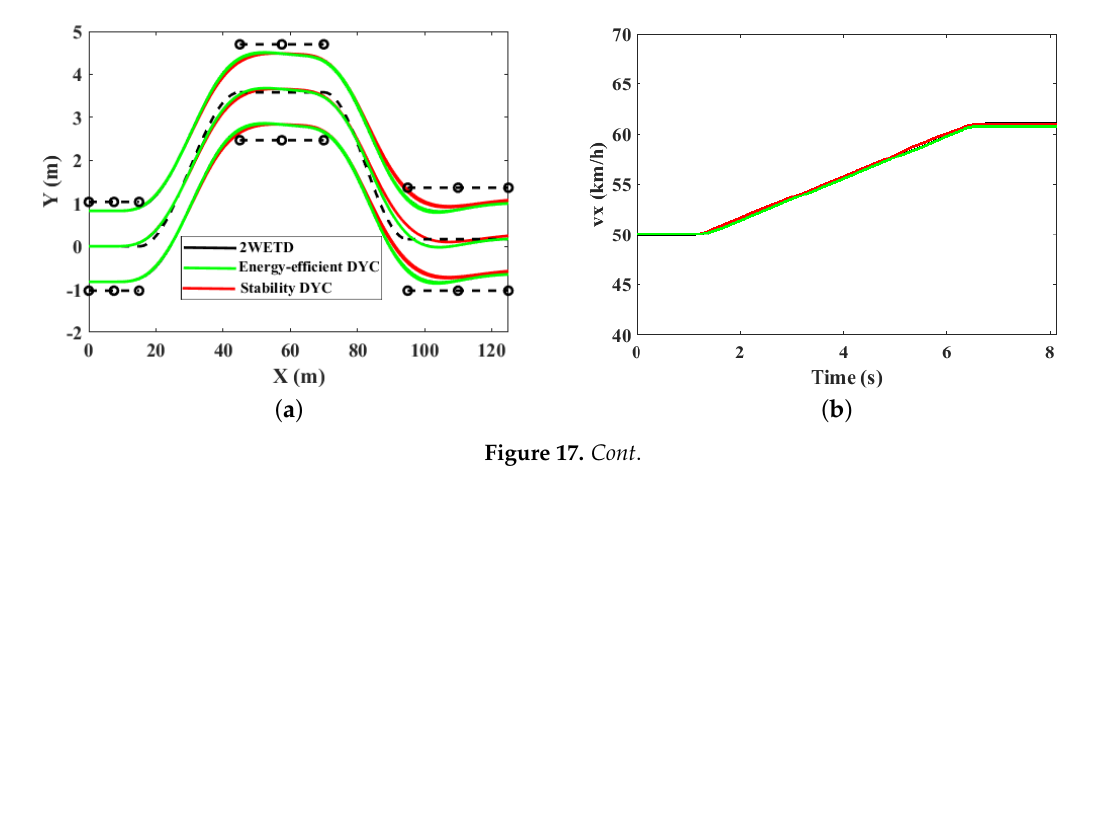
Figure 16. Extended double lane change with Motor II and v x = 80km/h: ( a ) Path; ( b ) Longitudinal velocity; ( c ) Working area; ( d ) Wheel torques; ( e ) Yaw moment; ( f ) Power; ( g ) Front steering angle; ( h ) Lateral acceleration.